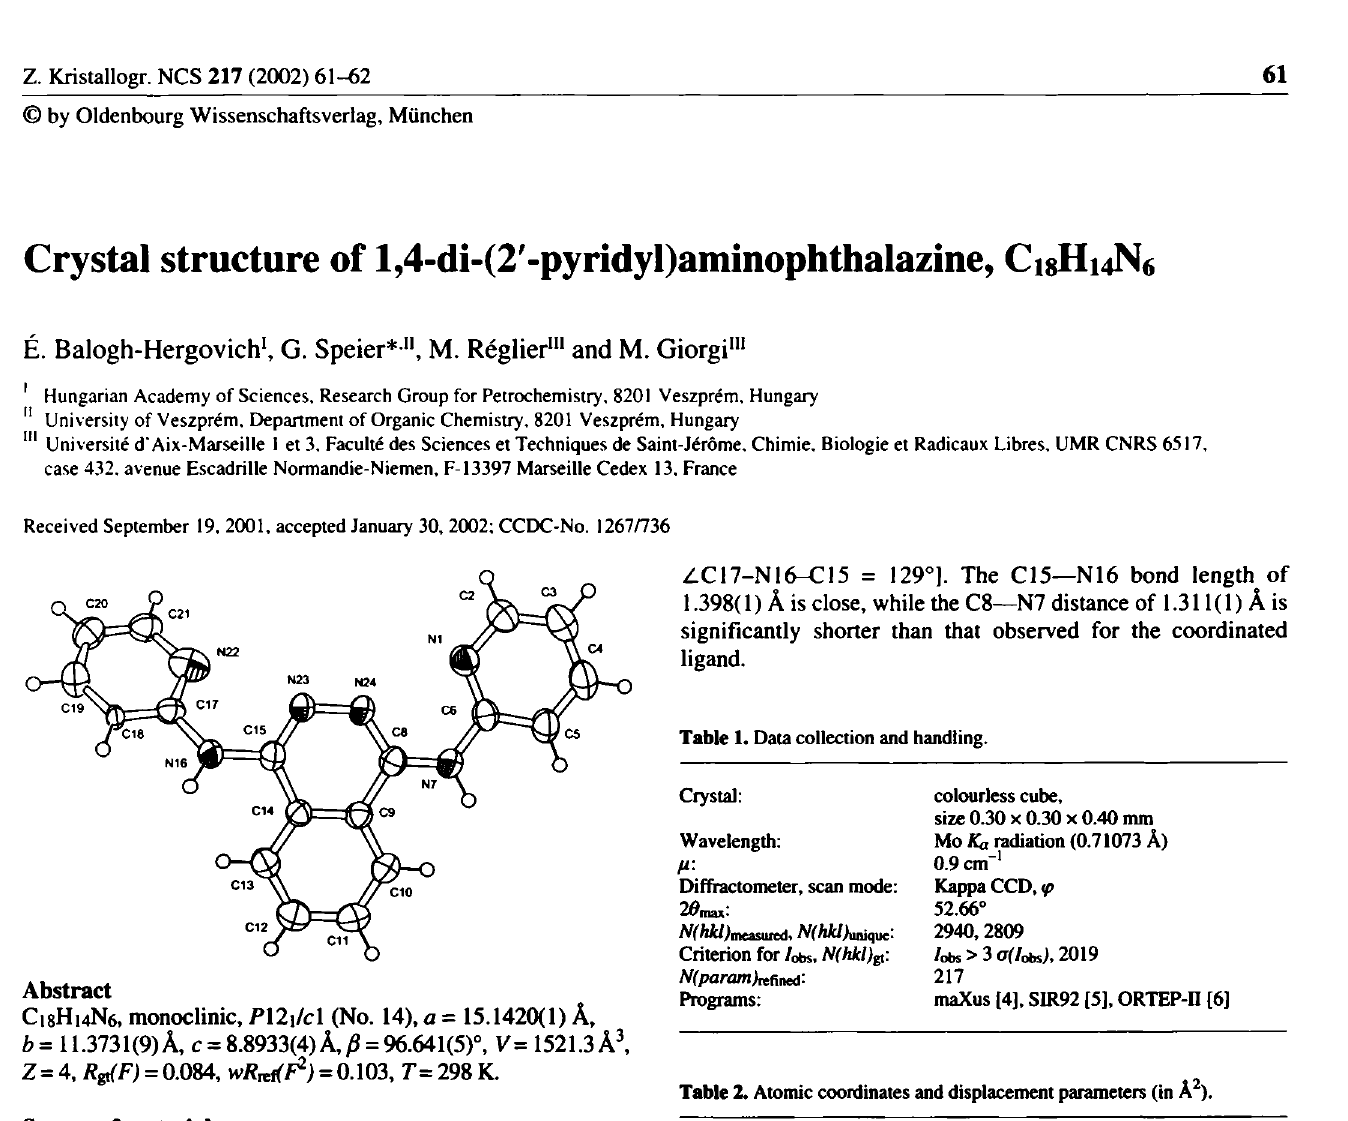
Table 2. Atomic coordinates and displacement parameters (in Â 2 ).